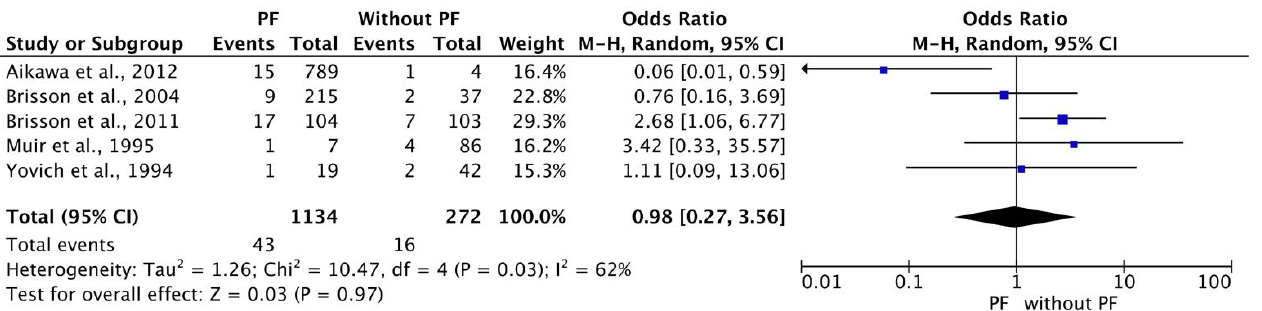
Figure 6. Meta-analysis for recurrence ratio (with prophylactic fenestrations; without prophylactic fenestration).